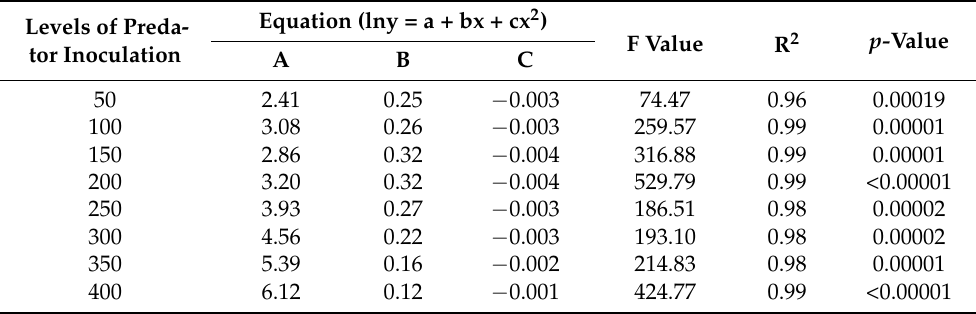
Table 1. Regressions between numbers of the predator Amblyseius tamatavensis produced in 500 mL containers and production periods on Thyreophagus cracentiseta , for different levels of predator inoculation ( n = 8 containers per predator